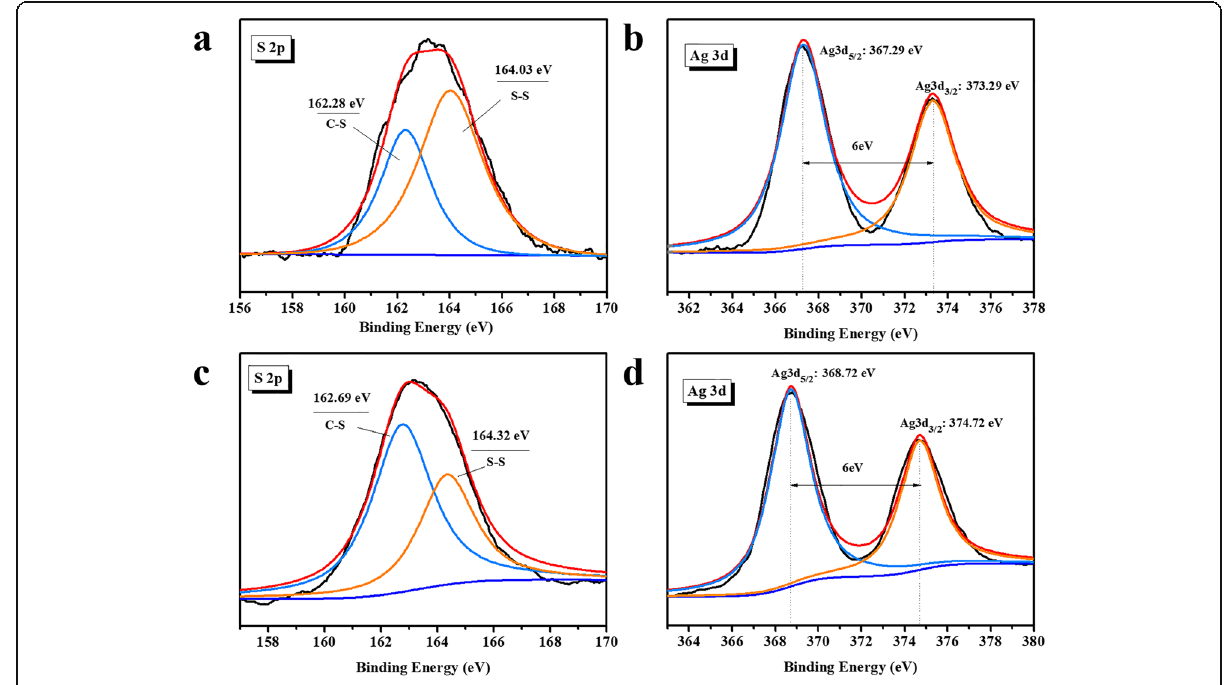
Fig. 5 XPS spectra of the samples in the S 2p region a CP, c LA-CP and in the Ag 3d region b GA@AgNPs-CP, d GA@AgNPs-LA-CP